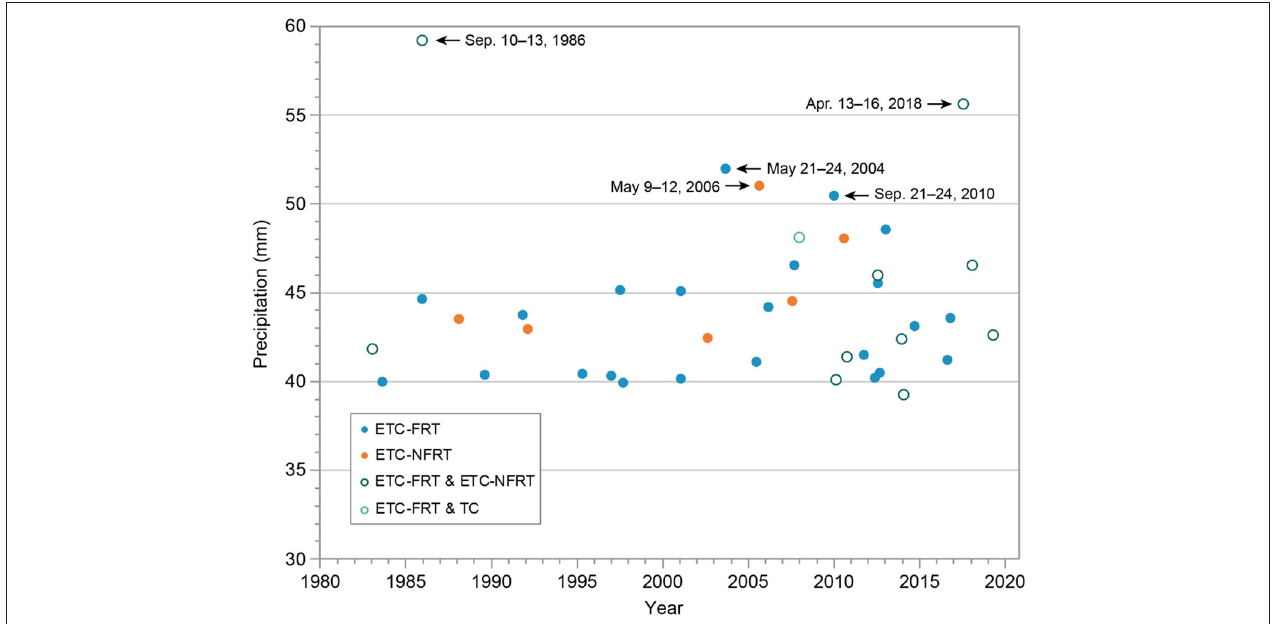
FIGURE 11 | Scatter plot of the 40 largest basin-wide events showing precipitation amounts and year of occurrence. The symbols indicate the meteorological cause(s). The open symbols indicate events with both a primary (ETC-FRT) cause and a secondary cause (either ETC-NFRT or TC). The dates of the 5 largest events are indicated next to the symbols.